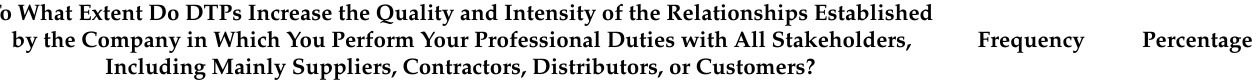
Table 8. The impact that DTPs have on relations with stakeholders Reprinted with permission; 2021, MDPI.